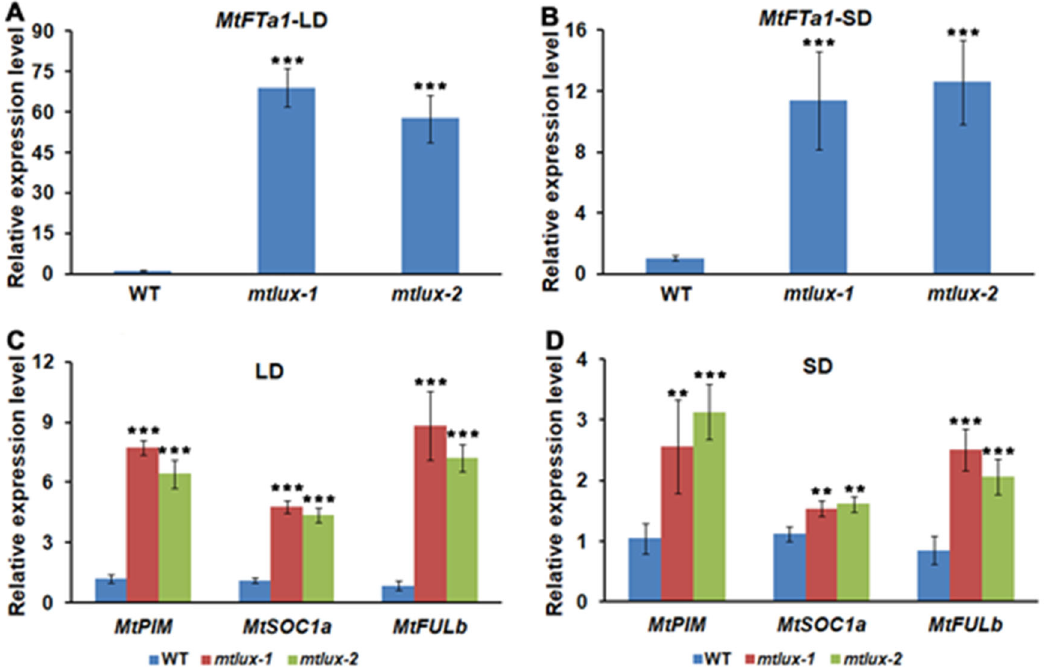
Figure 3. Transcript levels of flowering control genes. ( A , B ) Expression level of MtFTa1 in long ‐ day ( A ) and short ‐ day ( B ) in the leaves of 4 ‐ week ‐ old wild ‐ type and mtlux mutant. ( C ,D) Expression level of MtPIM , MtSOC1a , and MtFULb in long ‐ day ( C ) and short ‐ day ( D ) in the leaves of 4 ‐ week ‐ old wild ‐ type and mtlux mutant. Values are shown as means ± SD of three biological replicates. **, ***: means differ significantly ( p < 0.01, p < 0.001).